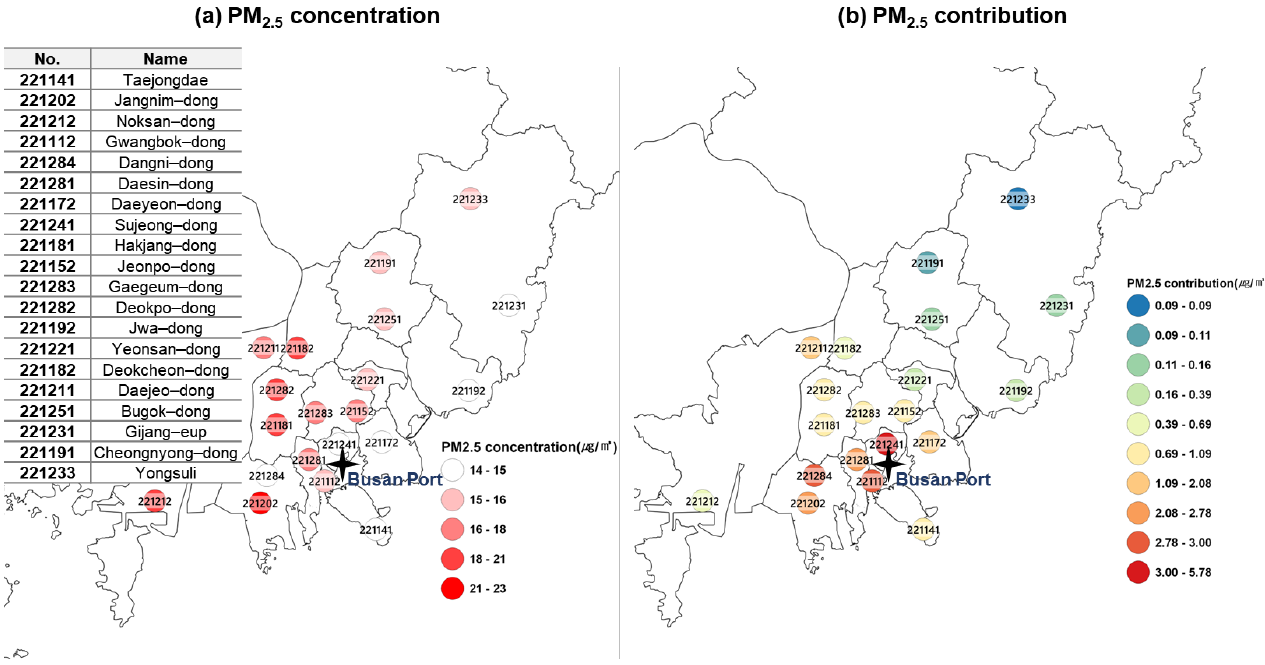
Figure 7. ( a ) Annual mean PM 2.5 concentrations (µg/m 3 ) at air quality monitoring sites in 2020 and ( b ) PM 2.5 contribution concentrations (µg/m 3 ) from ship emissions.